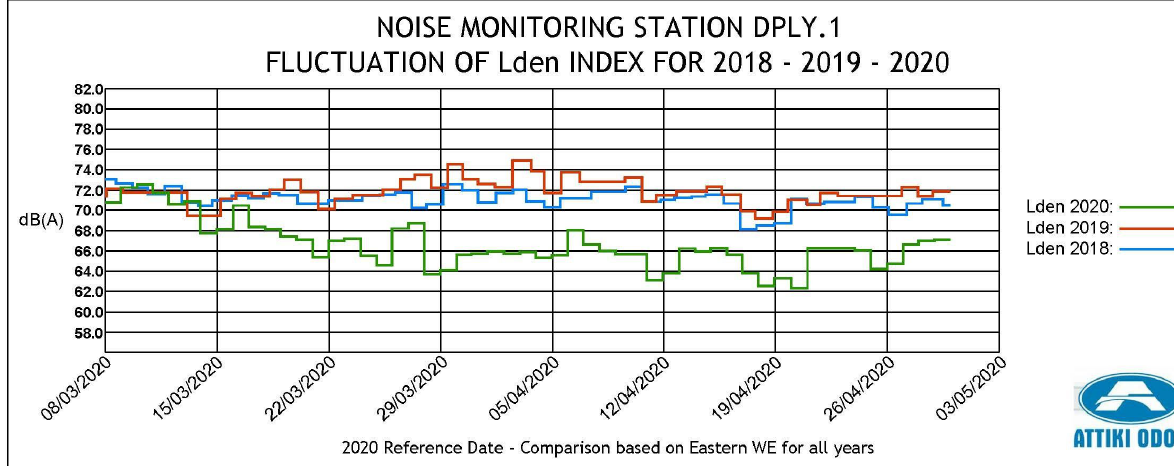
Figure 9g: Fluctuation of L den index – Noise monitoring station DPLY.1